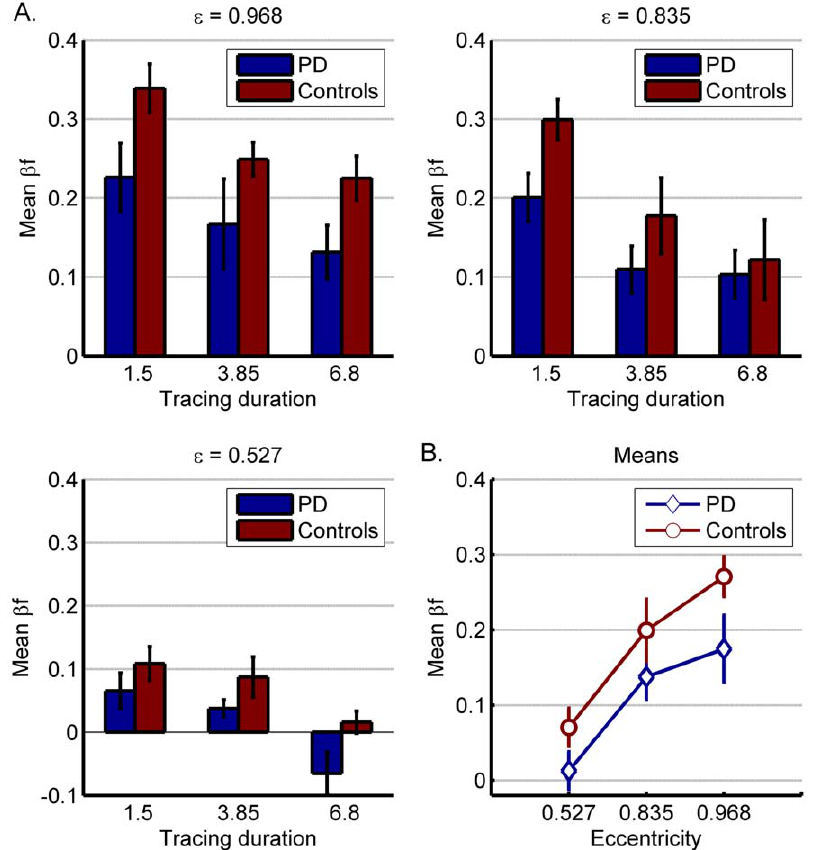
Figure 2. Mean b f values chosen by PD patients and controls, for each of the three different eccentricities (A) and across the effect of tracing speed (B). Error bars denote SE.